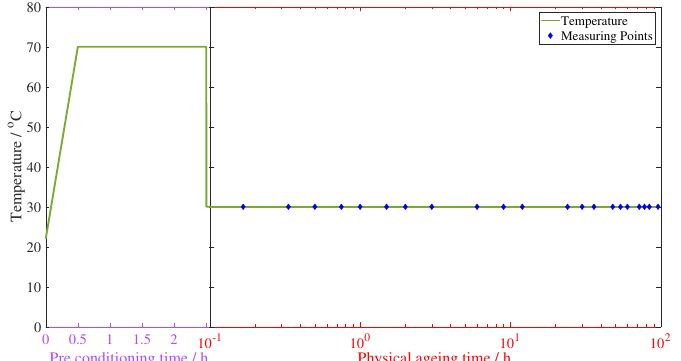
Figure 4. Temperature profile of the experimental procedure followed for each sample. The green line represents the temperature increase, annealing, crash cooling, and constant value until the end of the experiment. The blue diamonds mark the measurement times, the violet axis shows the preconditioning time in a linear time scale, and the red axis uses a logarithmic time scale to represent the physical aging time.